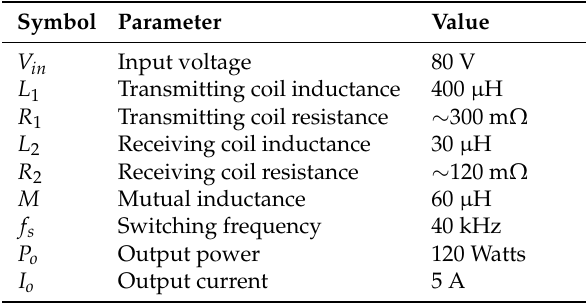
Table 1. Using Equations (9)–(11), the parameters of the compensation network were designed and are listed in Table 2. The parameters of the buck converter and DFTSMC are listed in Table 3. Table 1. Wireless charger